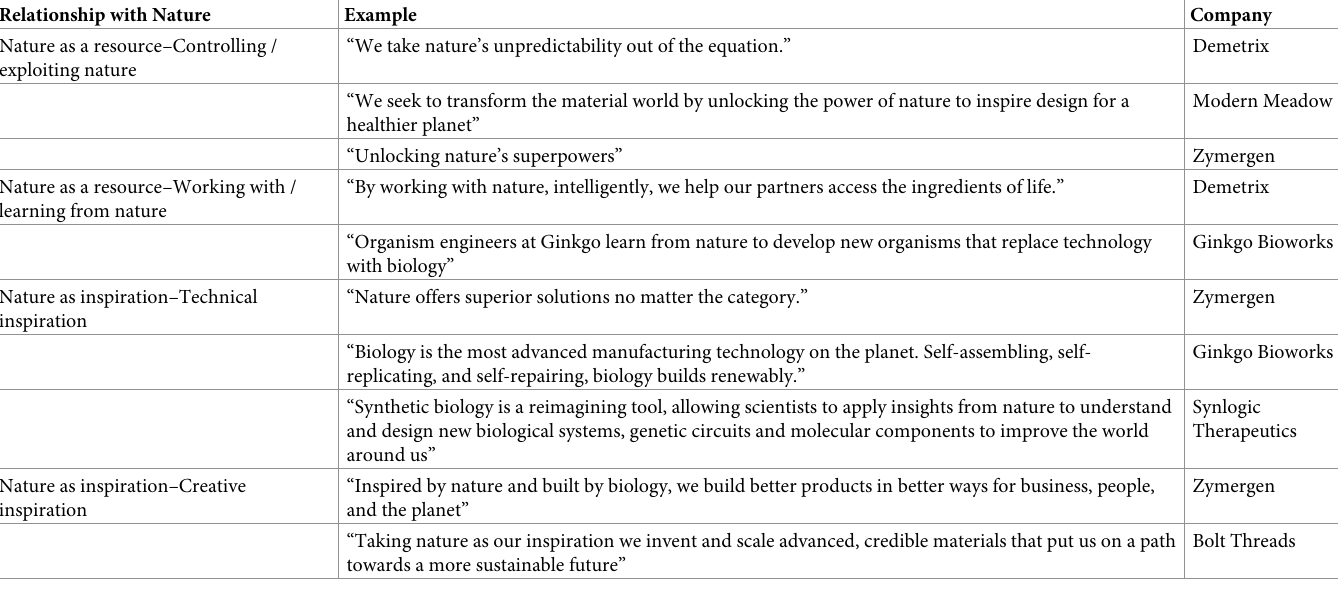
Table 3. References to nature on company